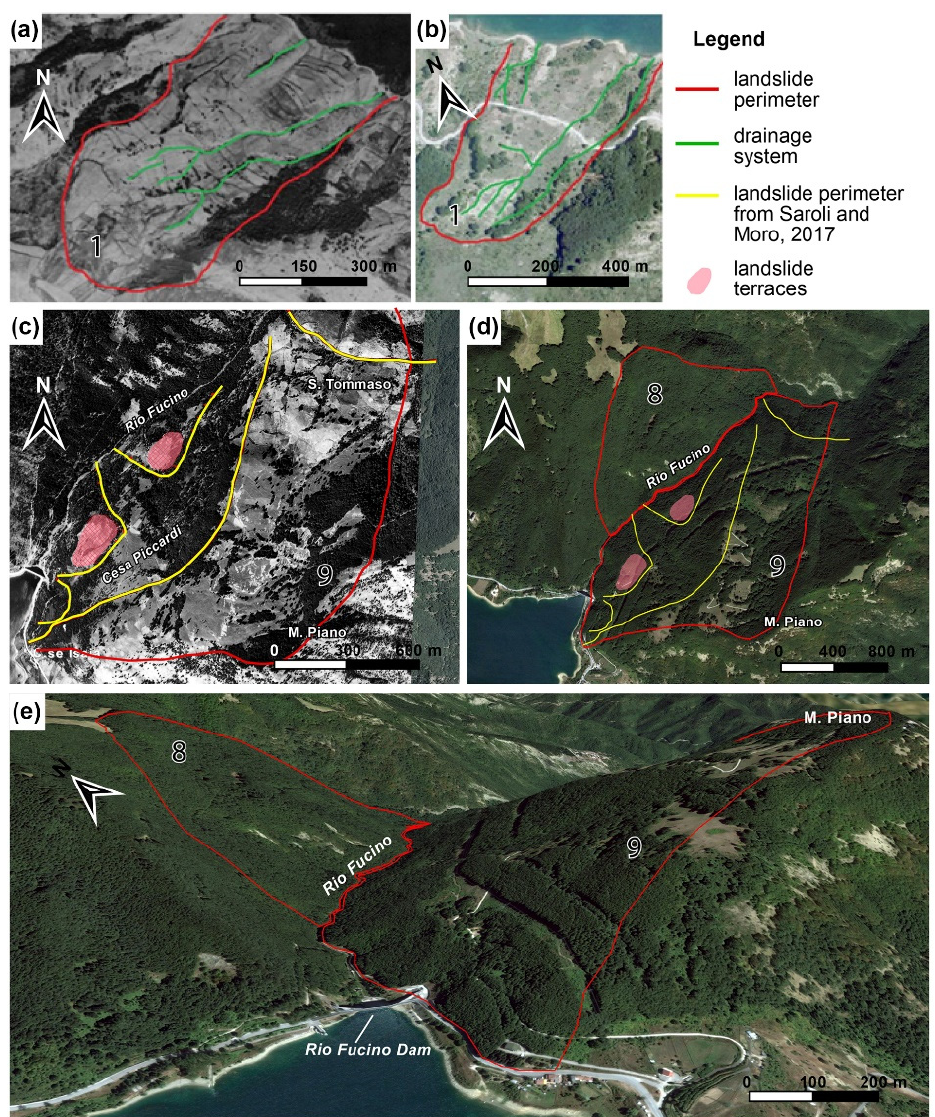
Figure 5. ( a , b ) Earthflow ID.1 represented in the aerial photographs “IGMI-G.A.I. 1954–1955” and “Abruzzo Region 2004–2005” respectively; ( c ) DsGSD ID.9 represented in the aerial photograph “Volo Base 1954”, with perimeter provided by Saroli and Moro [74]; ( d ) satellite view and ( e ) 3D view of the DsGSD ID.8 and ID.9 (from Google Earth).